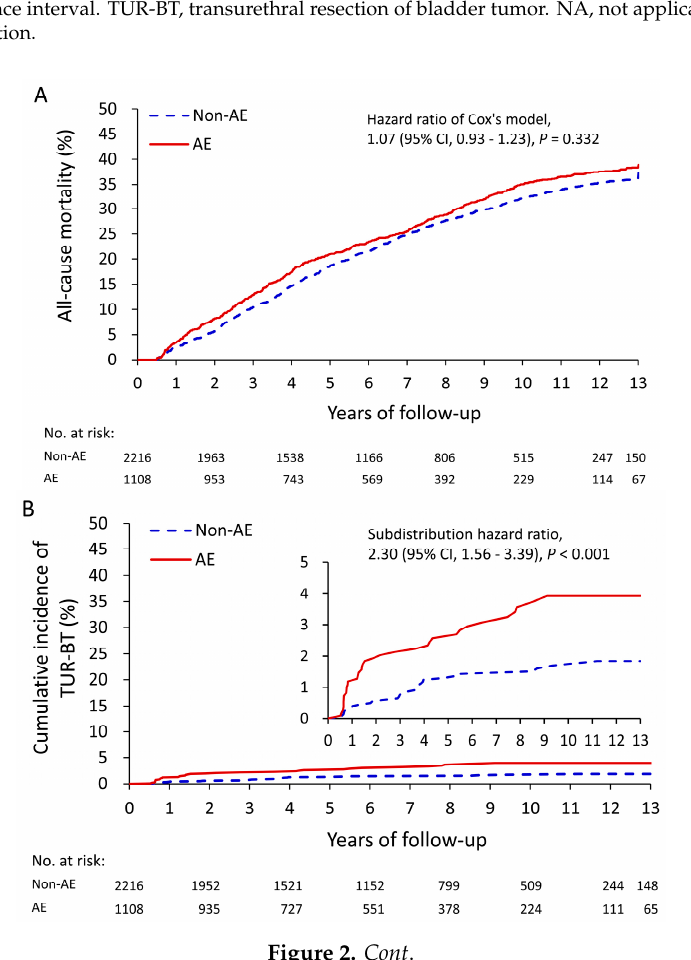
Table 4. Treatment outcomes during follow-up of patients with BPH who underwent TURP. AE vs. Non-AE AE Non-AE Variable Table 3. Treatment outcomes during follow-up of patients with BPH who underwent TURP. ( n = 1108) ( n = 2216) P Primary Outcome at the AE vs. Non-AE AE Non-AE Variable End of Follow Up ( n = 1108) ( n = 2216) HR / SHR (95% CI) P All-cause mortality Primary Outcome at the End of Follow Up All-cause mortality 431 (38.9) Radical cystectomy NA Prostate cancer Secondary outcome during three-year follow-up Medication dependence three-year follow-up Anti-muscarinic Medication dependence Alpha-blocker